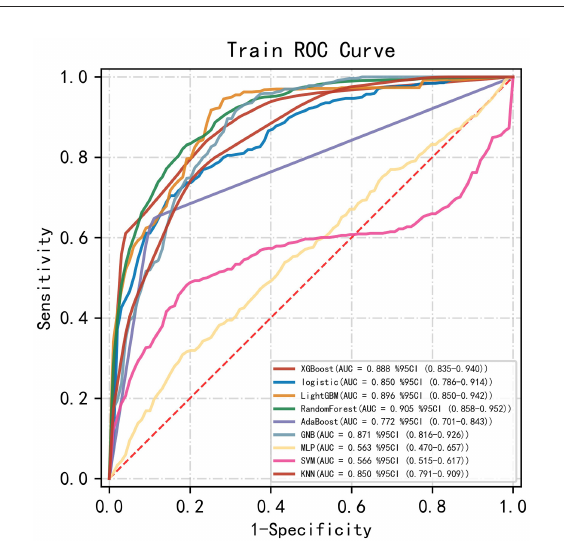
FIGURE3 Comparisons of different machine learning models in the area under the receiver operating characteristic curve (AUC) in the training set. RF, random forest; GNB, Gaussian NB; MLP, multi-layer perceptron neural network; SVM, support vector machine; KNN, k-nearest